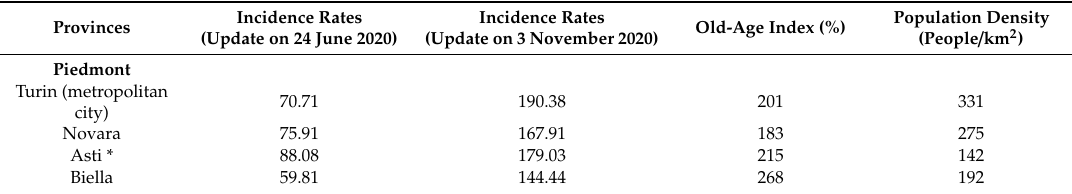
Table 1. COVID-19 incidence rates × 10 4 people, old-age index and population density stratified by Italian provinces and metropolitan